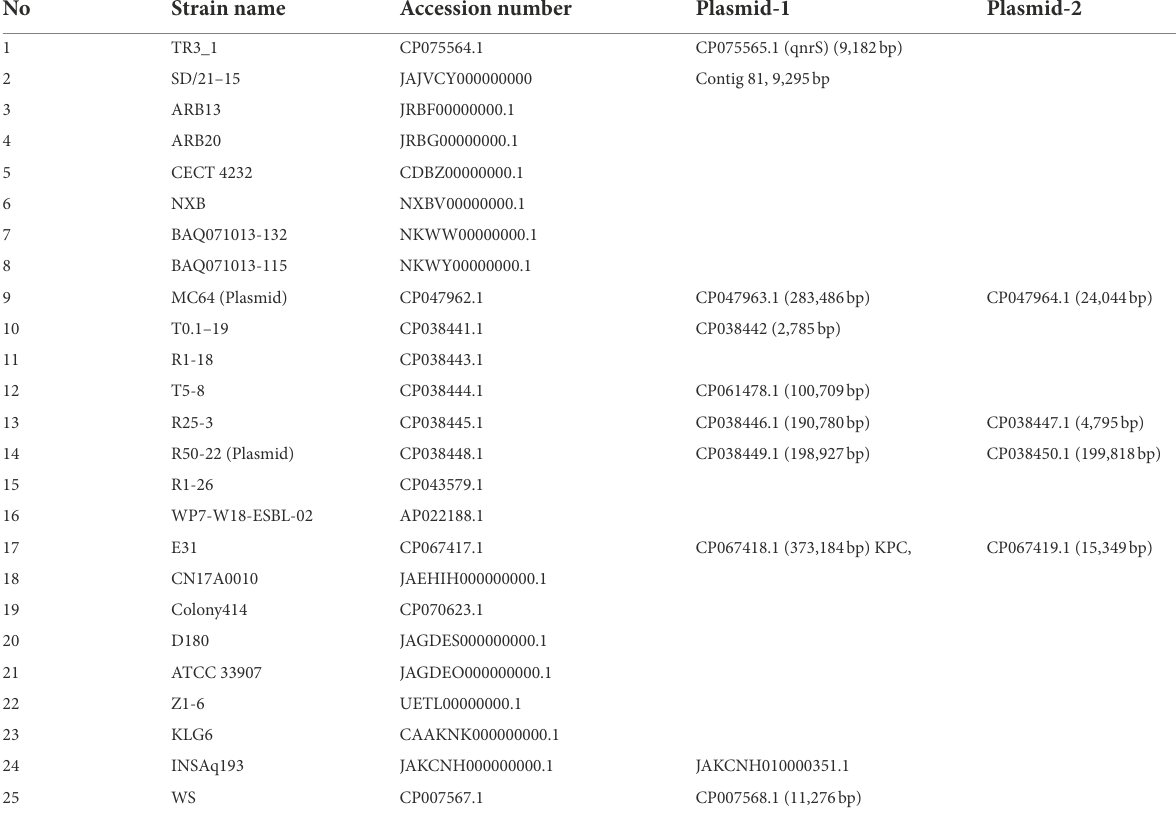
TABLE 6 Plasmids detected in the Aeromonas media whole genome